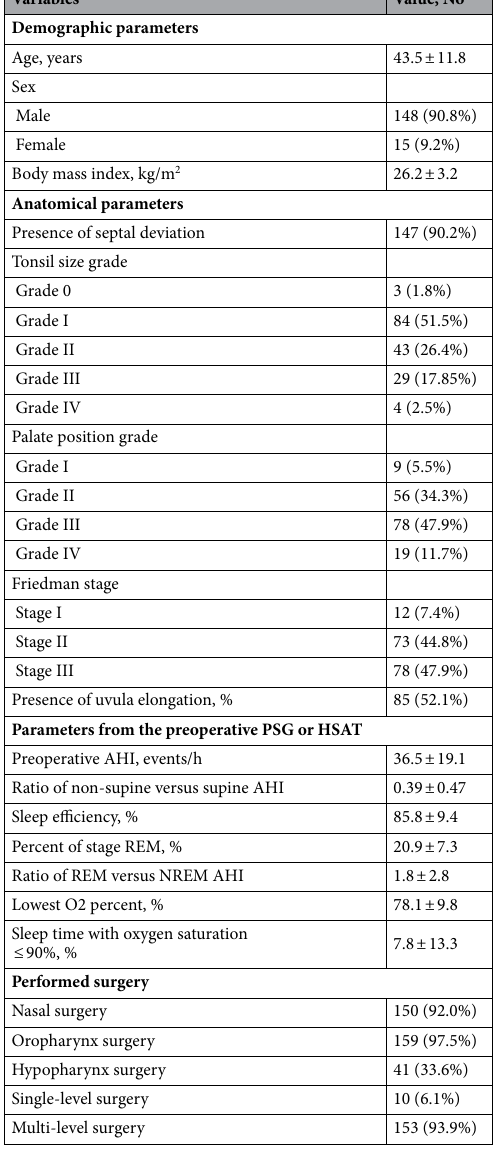
Table 1. Clinical characteristics and management of 163 subjects. AHI apnea hypopnea index, REM rapid eye movement, NREM non-rapid eye movement. Values are presented as mean ± SD or numbers